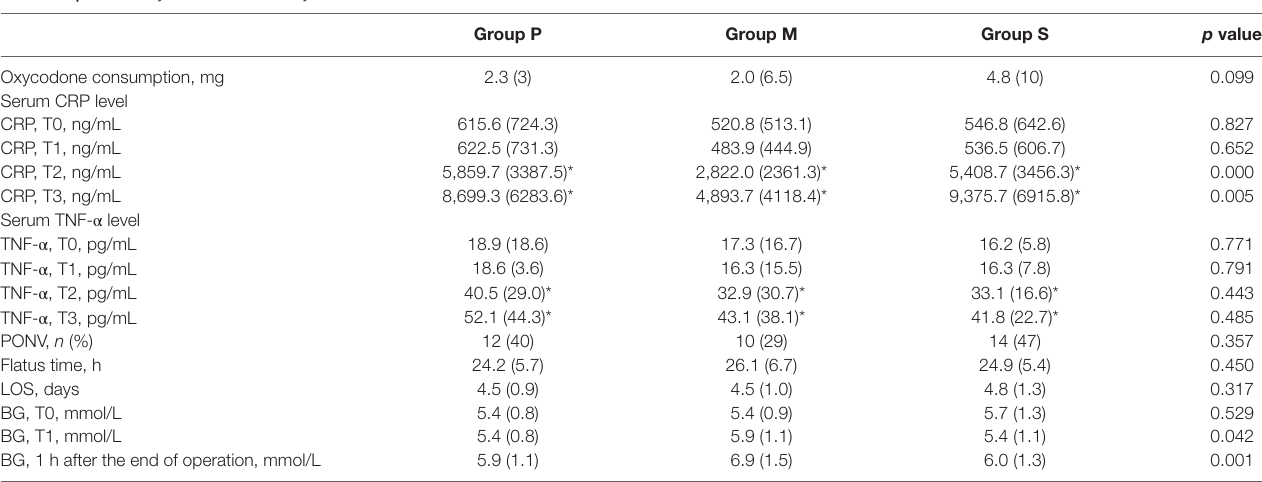
TABLE 3 | Secondary outcomes of study.